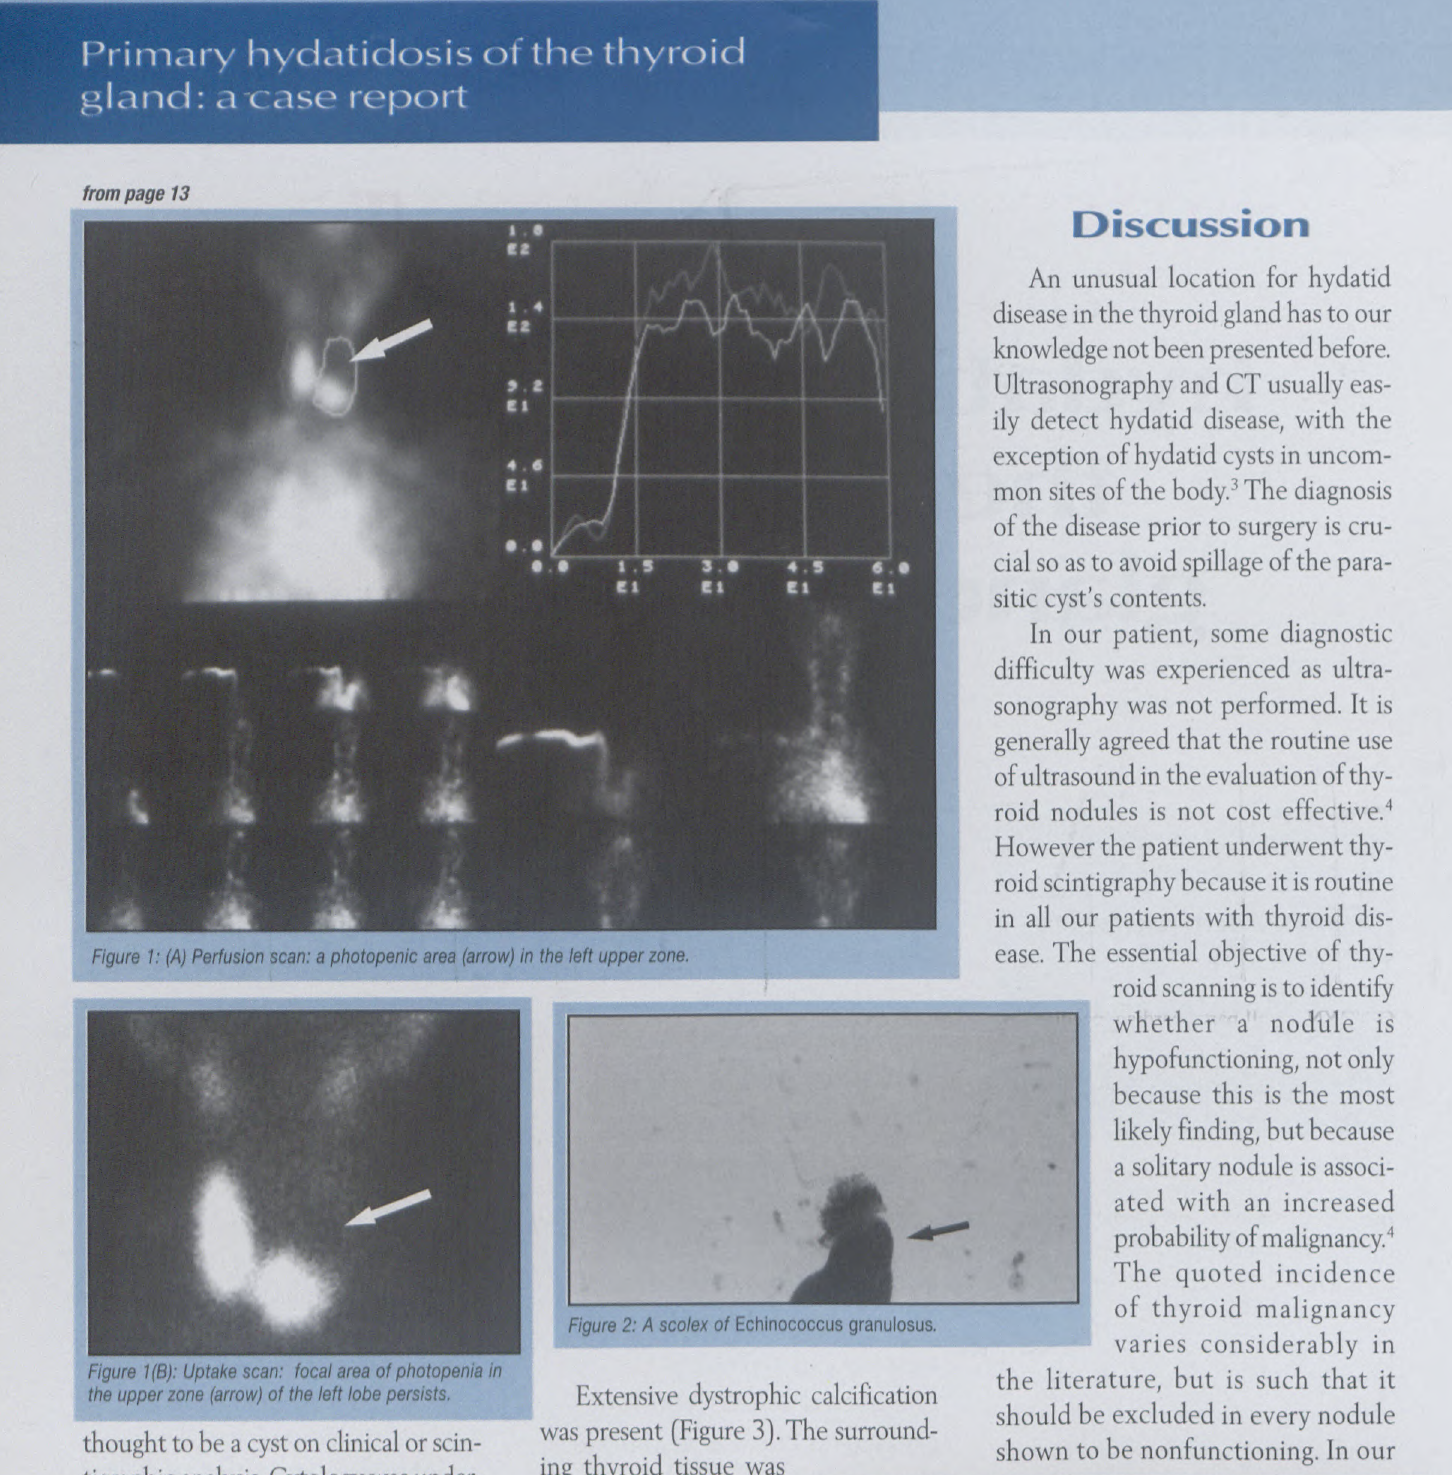
Figure 2: A scolex of Echinococcus granulosus.